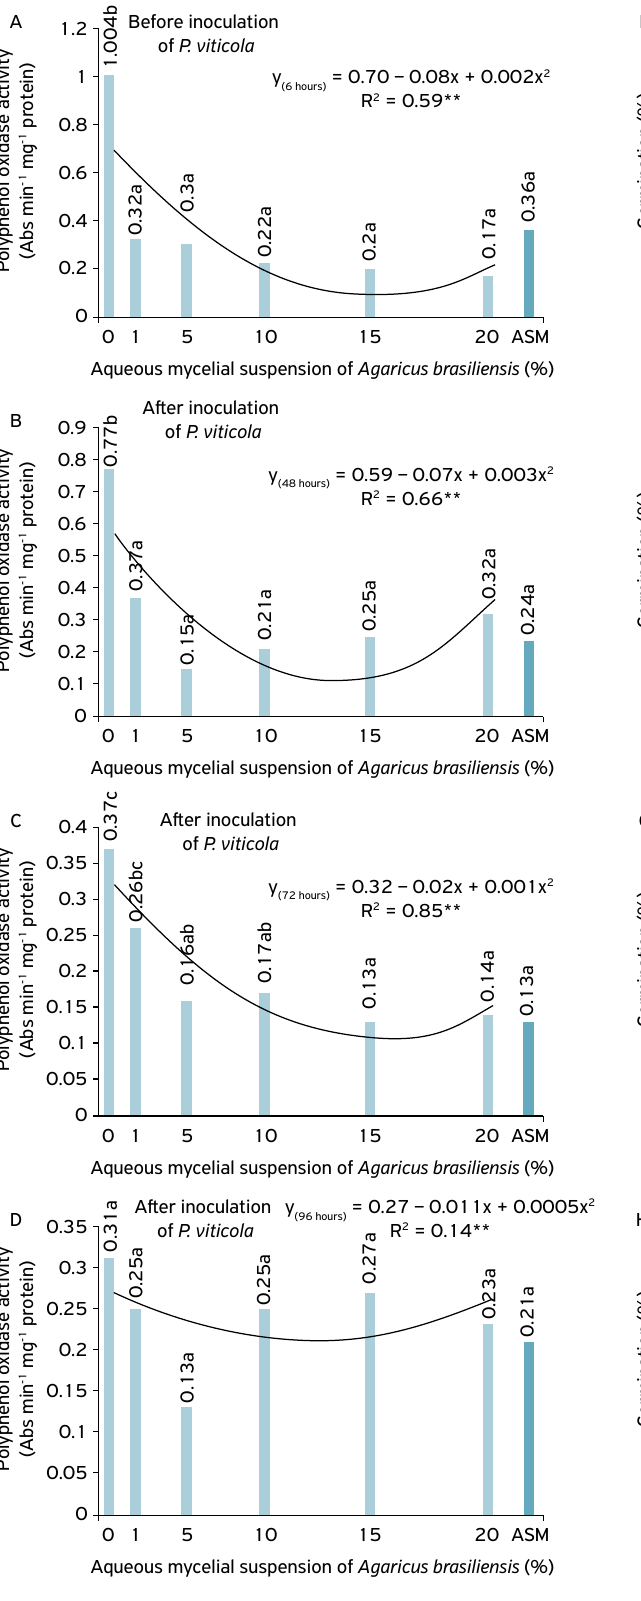
Figure 1. Polyphenol oxidase activity (PPO) on vine discs (‘Isabel Precoce’), treated with the doses of 1, 5, 10, 15 and 20% of the aqueous mycelial suspension (AMS) of Agaricus brasiliensis , Acibenzolar‑S‑methyl (0.005 %) and absolute control collected in the periods of 6h (A), 48h (B), 72h (C) and 96h (D), after the treatments. Germination of Plasmopara viticola sporangia submitted to doses of 1; 5; 10; 15; 20% AMS Agaricus brasiliensis , absolute control and acibenzolar‑S‑methyl (ASM) (0.005%). In the periods of: (E) 4h; (F) 6h; (G) 12h and (H) 24h, after application of the